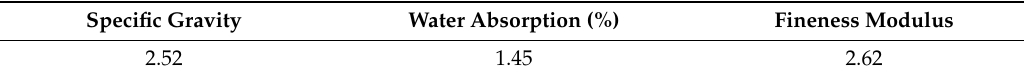
Table 4. Physical properties of the used fine aggregates.